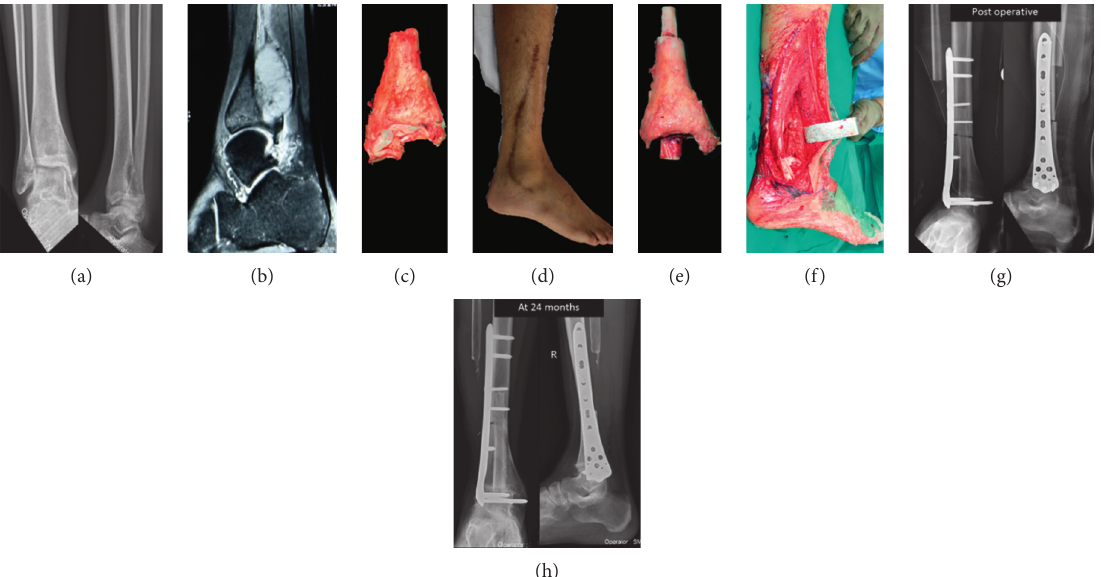
Figure 2: A 16-year-old male presented with a radiograph (a) and MRI (b) suggestive of a distal tibia osteosarcoma that was confirmed on a core needle biopsy. The distal tibia resection was performed with a bone margin of 2 cm and a soft tissue margin of healthy cover over the tumor (c). Procedure was performed through the anterolateral approach to allow tumor resection, fibula to be harvested, and adequate muscle cover over the lateral fixation after implantation (d). Following extracorporeal irradiation, the distal tibia tumor bone was prepared for reimplantation and the ipsilateral nonvascular fibula was inserted intramedullary spanning across both junctions (e). The construct was placed into the defect after the talus dome was prepared to achieve bony surface (f). After the fibula is confirmed to be across the proximal and distal junctions, a locking plate was used for fixation (g). Healed proximal osteotomy junction and fused ankle arthrodesis junctions with the fibula healing and incorporation seen on the latest follow-up radiograph